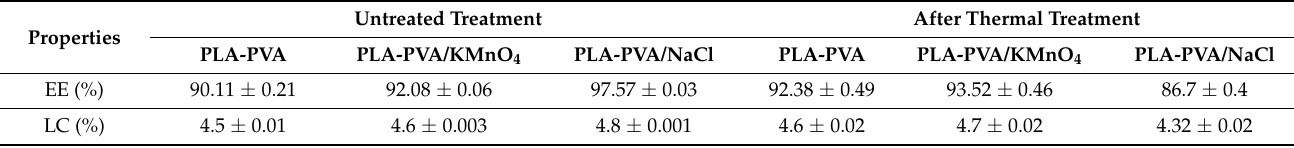
Table 5. Encapsulation efficiency (EE) and loading capacity (LC) of the porous bioscaffolds before and after thermal treatment.